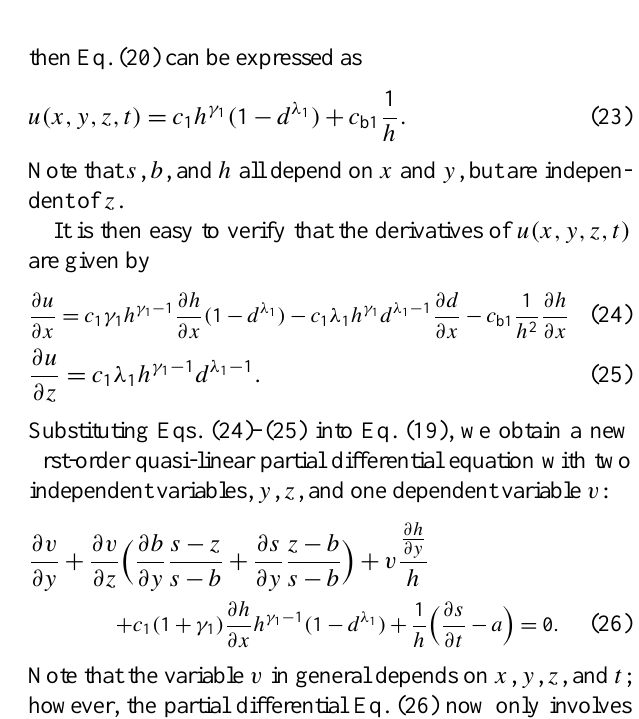
Fig. 2. Analytical solution at the top surface of the ice sheet. From left to right: the velocity components u , v , and w (ma − 1 ) and the pressure p (10 5 Pa). From top to bottom: t = 0, 100, and